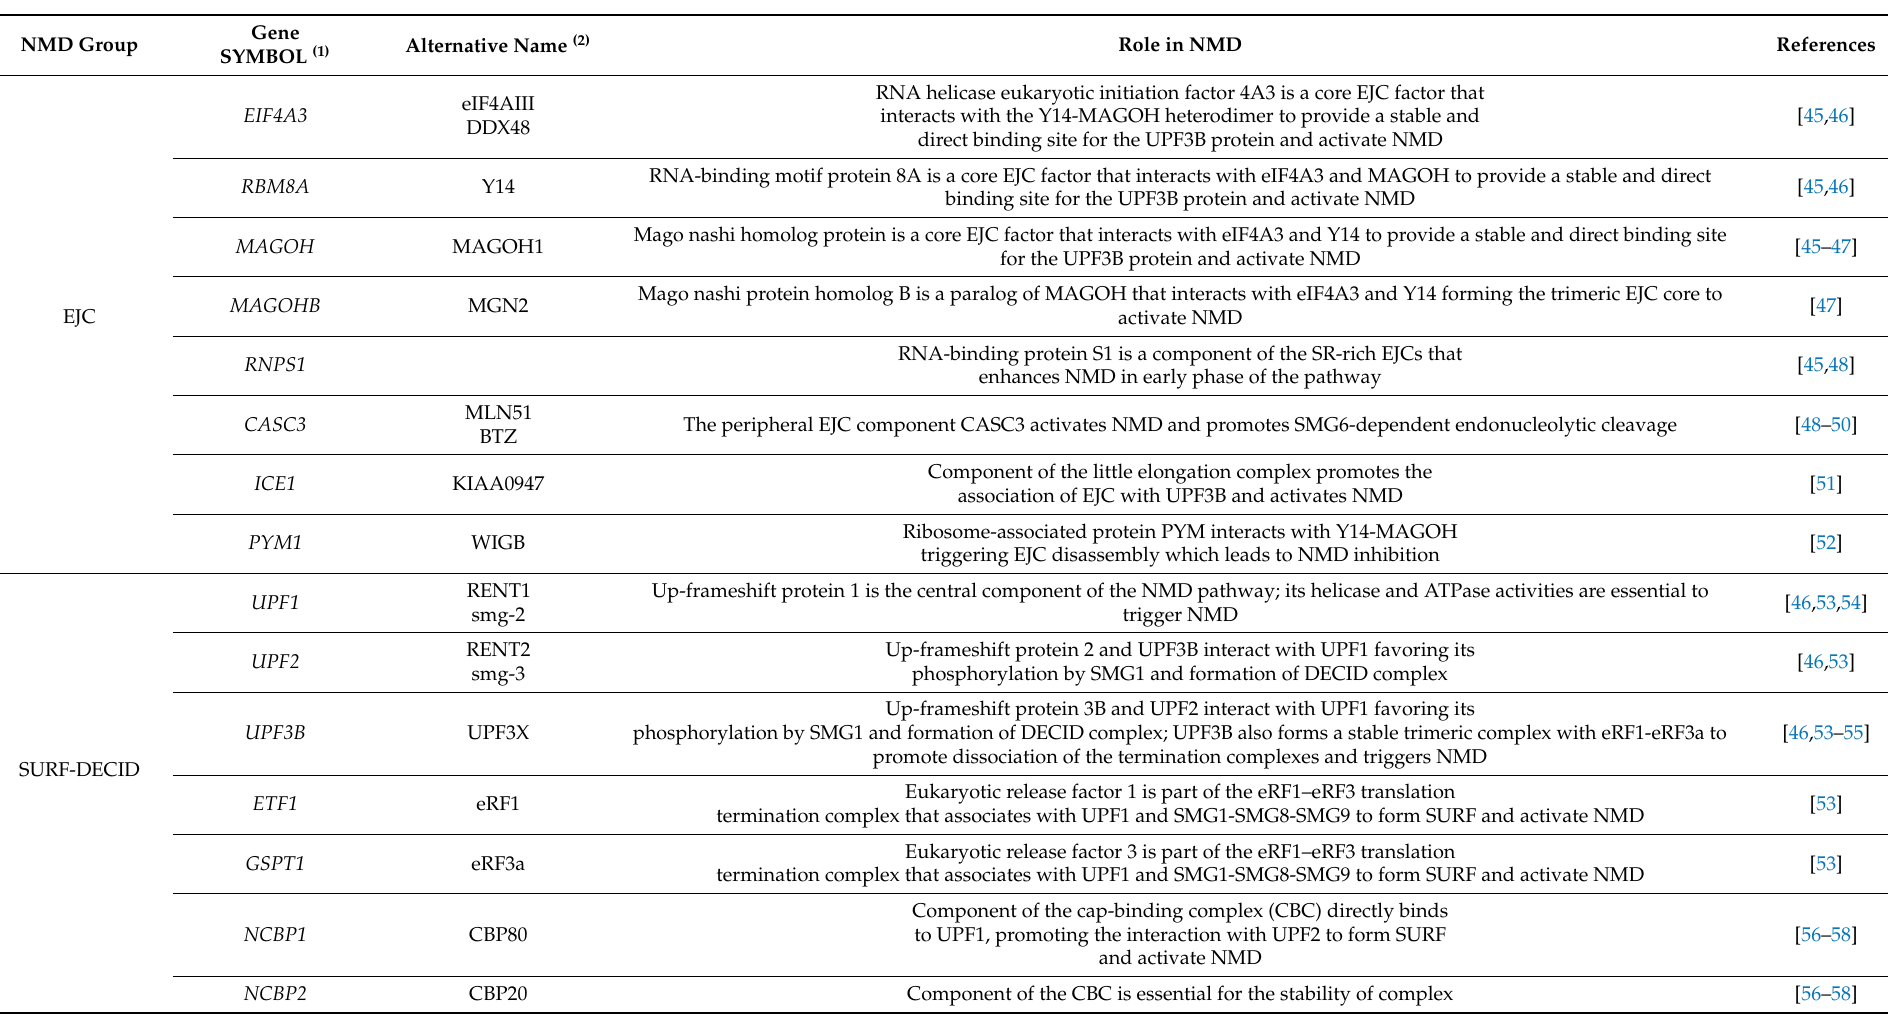
Table 1. List of human genes encoding NMD factors and